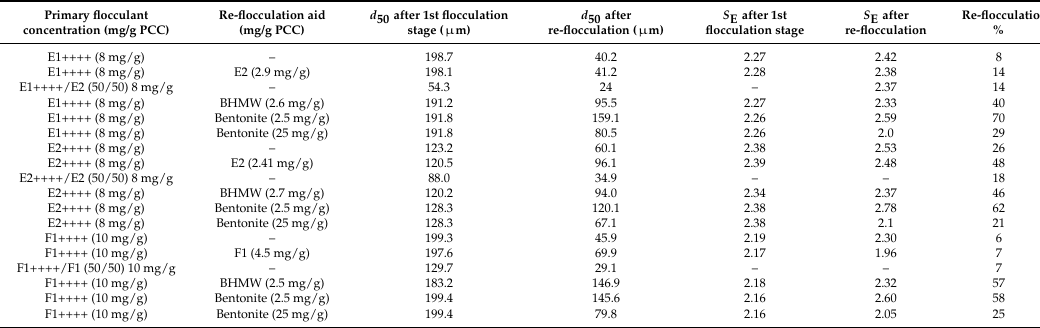
Table 3. Summary of flocculation and re-flocculation